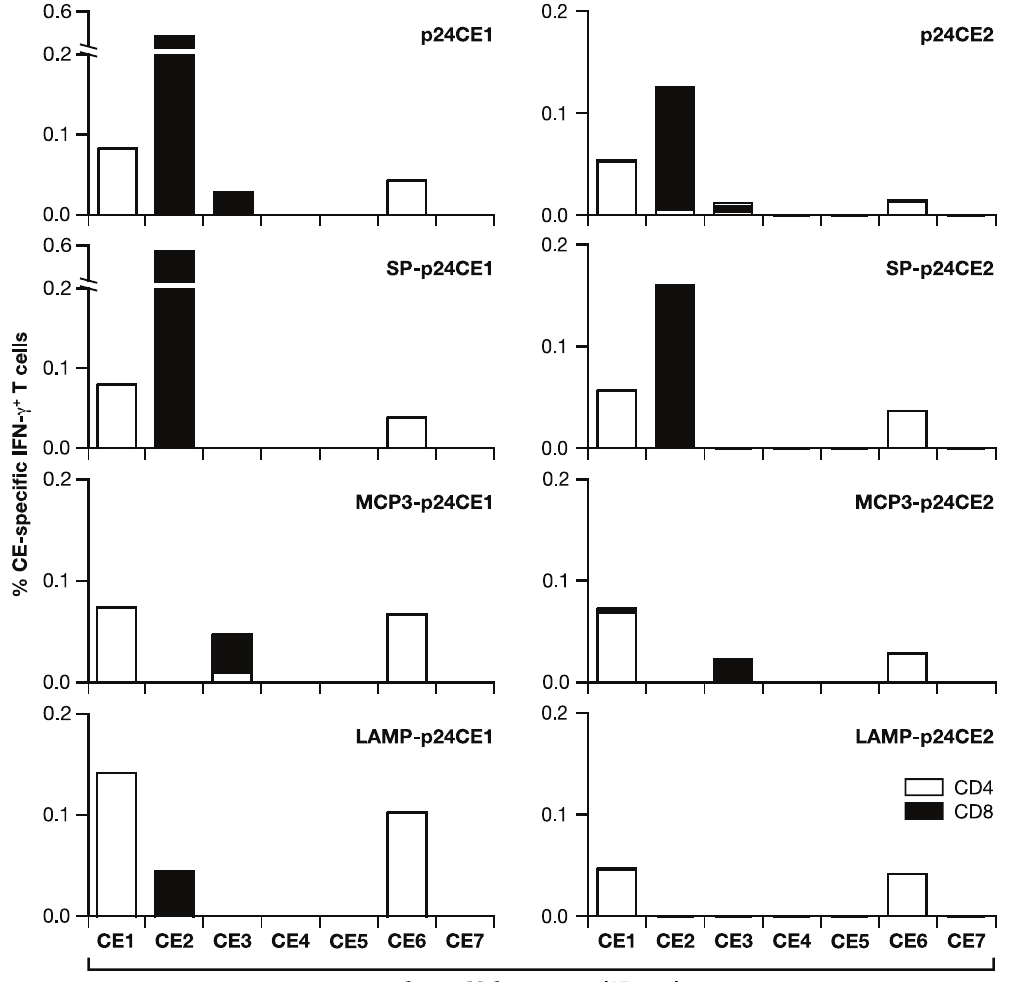
Figure 4. Mapping of the p24CE-induced cellular immune responses. Pooled splenocytes from C57BL/6 mice (N=5) vaccinated with the indicated p24CE1 (left panels) or p24CE2 (right panels) DNAs were stimulated with the Group M Consensus peptide pools (15-mers overlapping by 11 AA) spanning the individual CEs. The frequency of CE-specific IFN- c producing T cells was measured. CD4 + (open bars) and CD8 + (filled bars) Gag- specific T cells are shown.